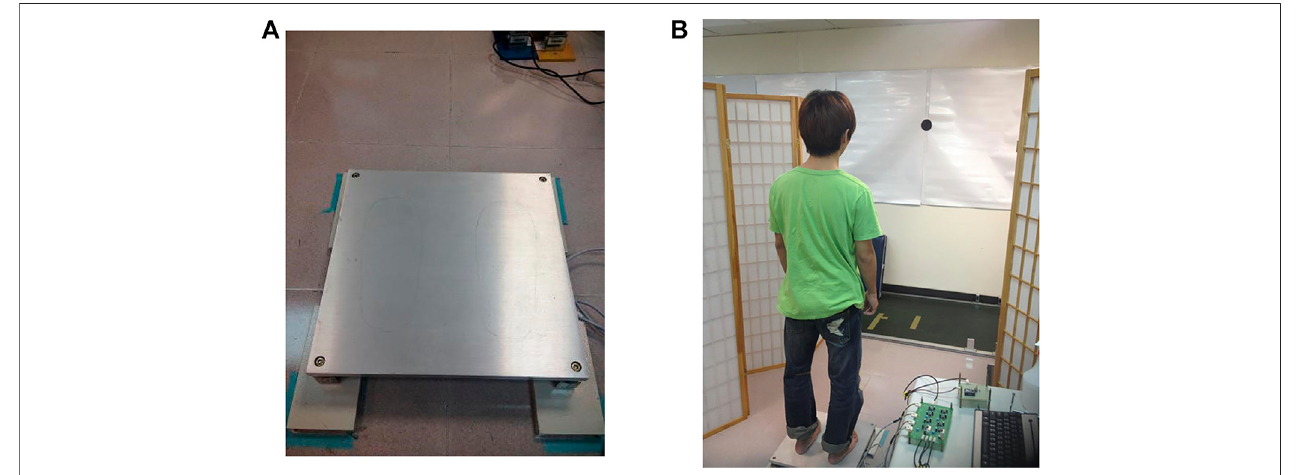
FIGURE 1 | (A) The proposed low-cost force plate and (B) The experimental